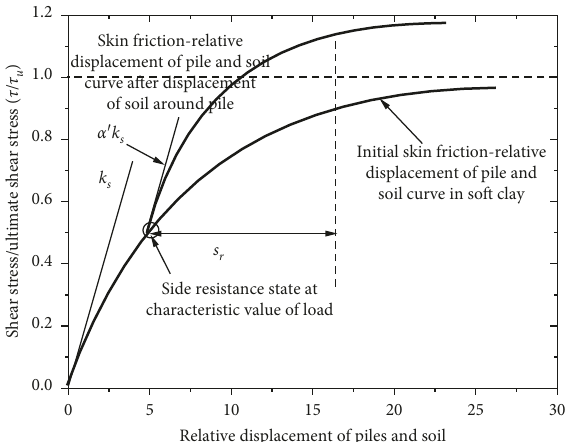
Figure 4: Calculation model of negative lateral resistance and relative displacement of pile and soil.